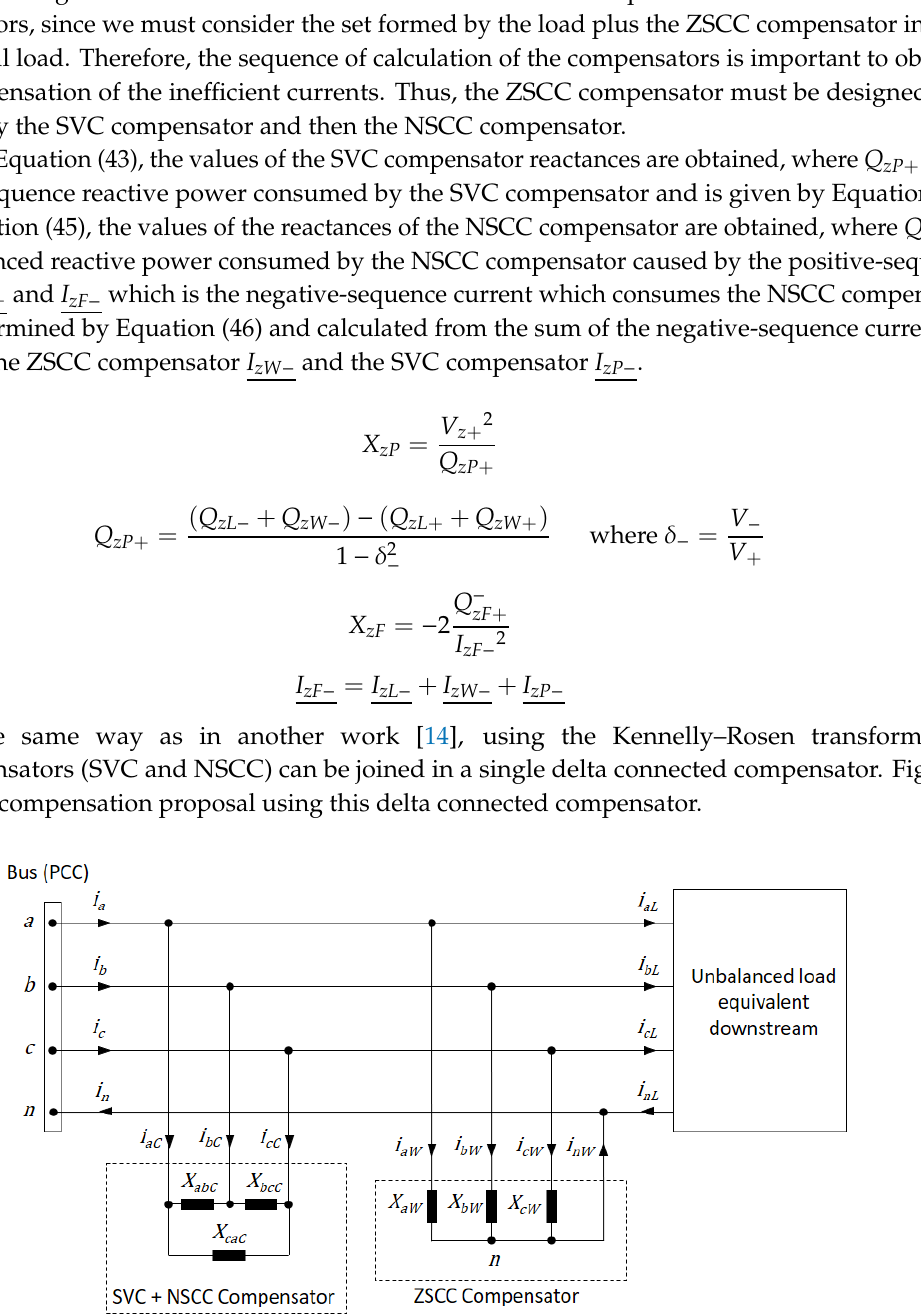
𝑉 𝑐𝑛 = 195.00 𝑒 𝑗90 Figure 8. Proposed system for practical application.